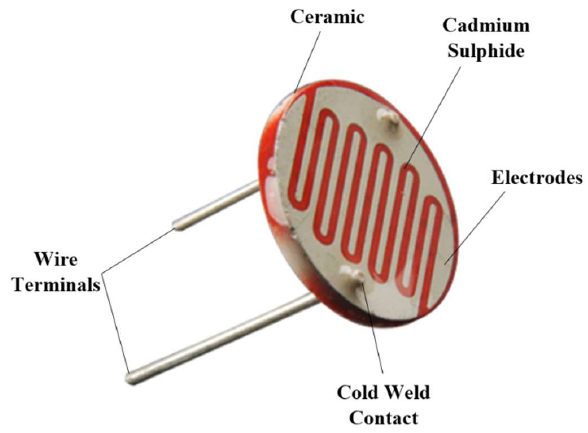
Figure 8. Light Dependent Resistor.